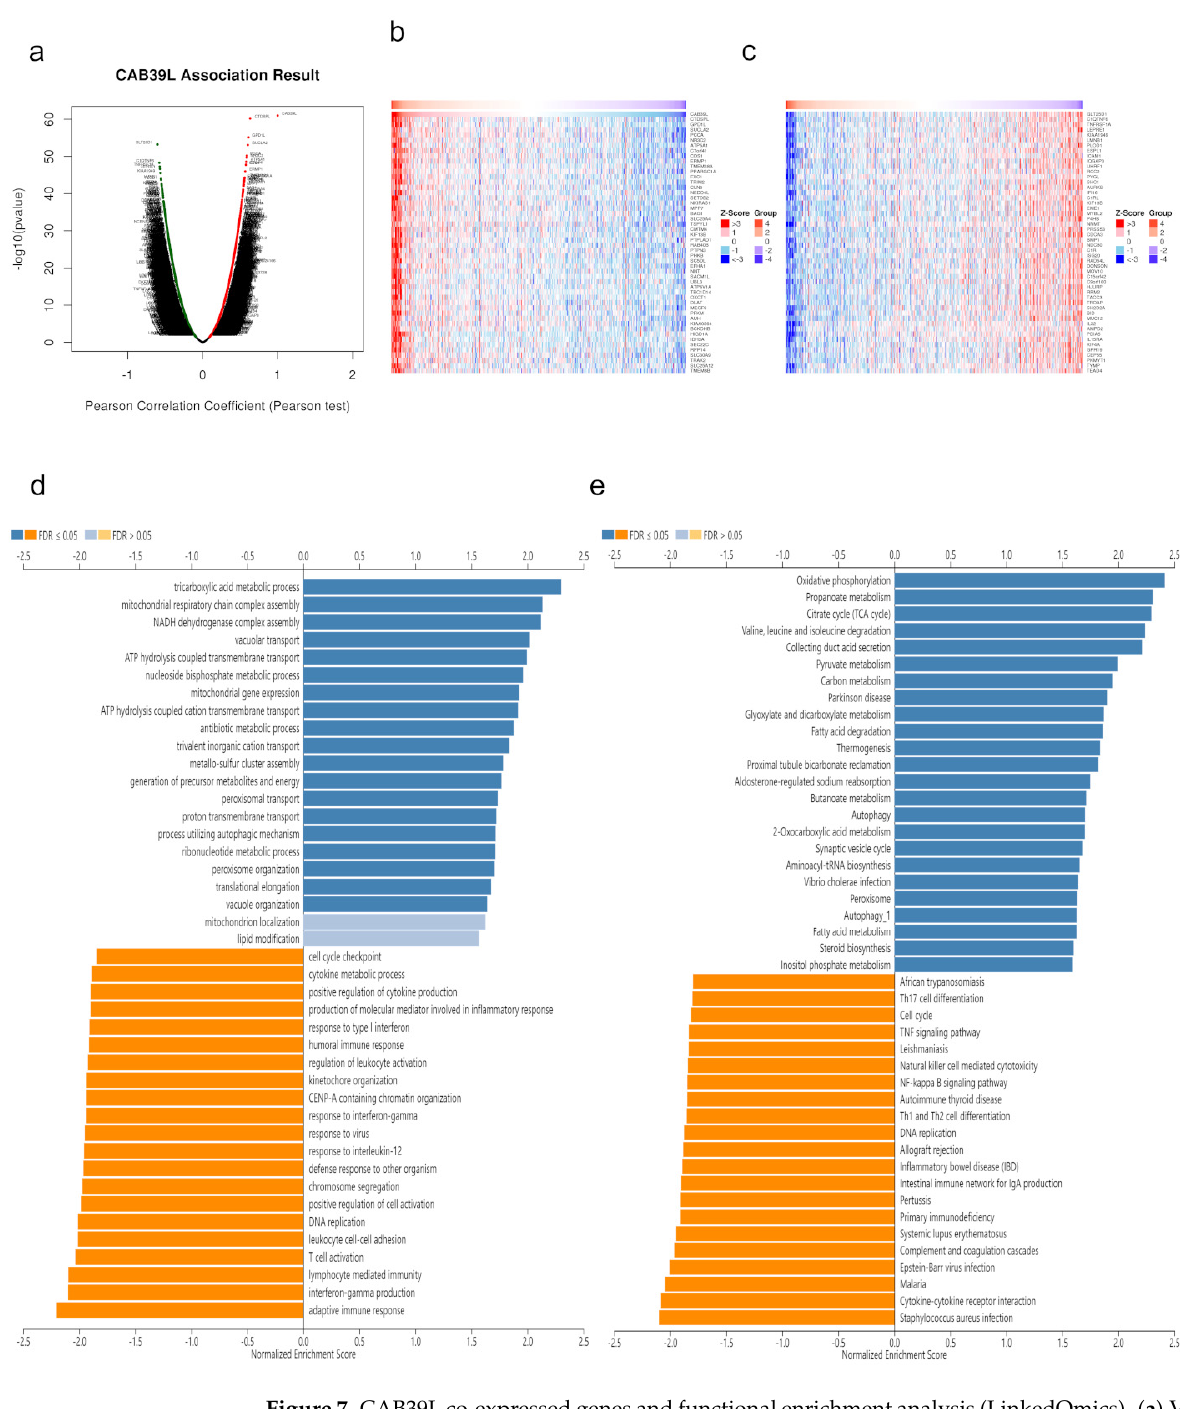
Figure 7. CAB39L co-expressed genes and functional enrichment analysis (LinkedOmics). ( a ) Volcano map of CAB39L co-expressed genes in KIRC. ( b ) Fifty genes positively associated with CAB39L. ( c ) Fifty genes negatively associated with CAB39L. ( d ) GO enrichment analysis of CAB39L co- expressed genes. ( e ) KEGG enrichment analysis of CAB39L co-expressed